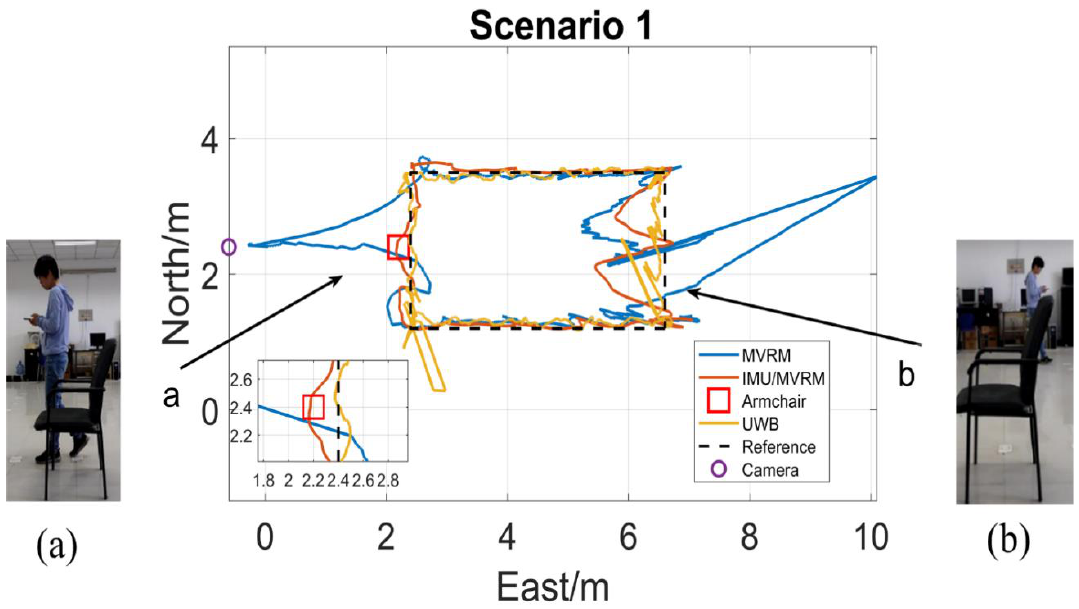
Figure 13. The horizontal trajectory in armchair scenario. ( a ) The armchair blocked the view of the camera from seeing the test person at the marker 10th, and failed to detect the person; ( b ) the armchair blocked the view of the camera from seeing the test person near the marker 22nd, and failed to detect the person.